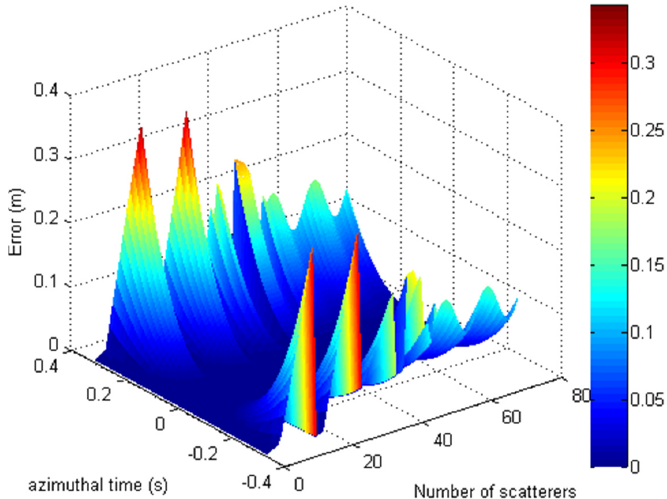
Figure 6. The phase error of approximation operation.